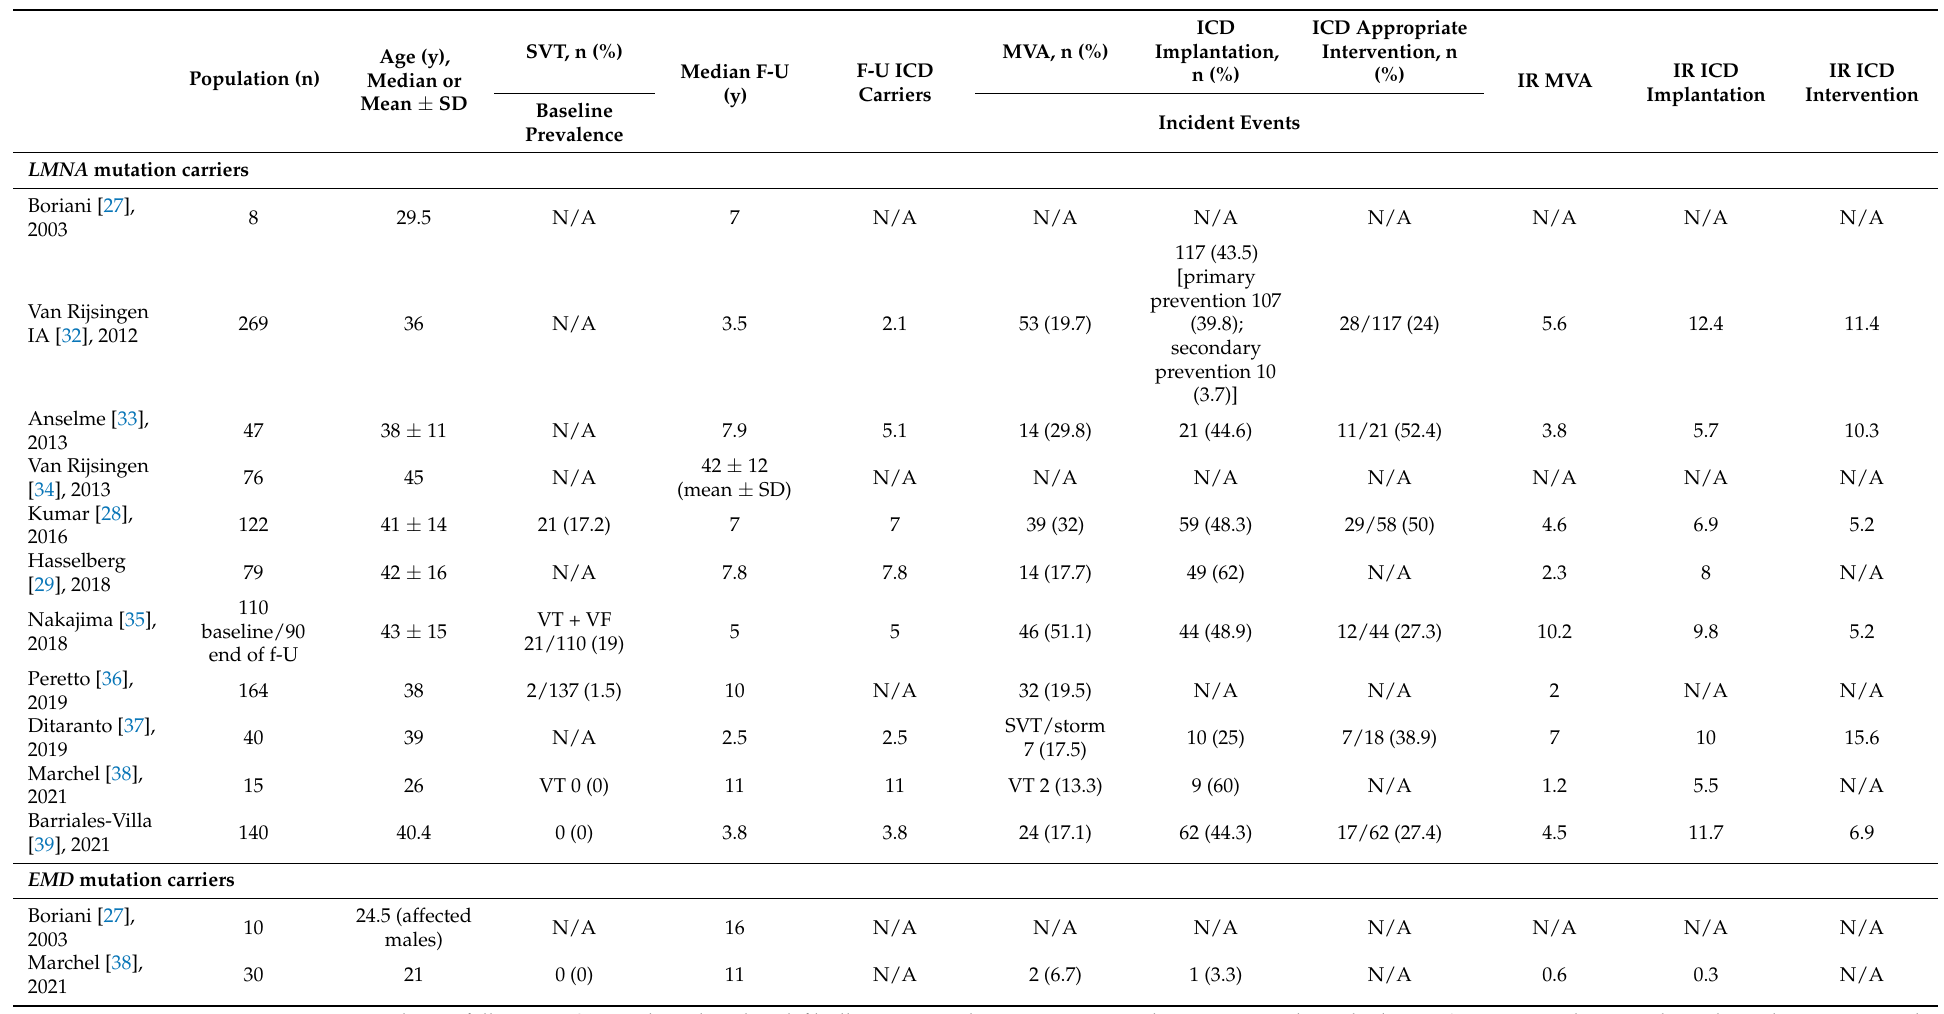
Table 4. Ventricular arrhythmic